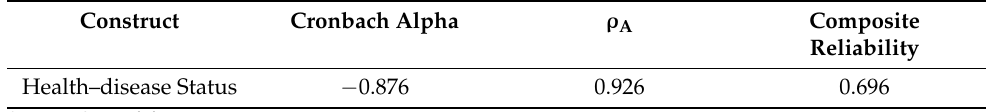
Table 6. Construct reliability HOC.